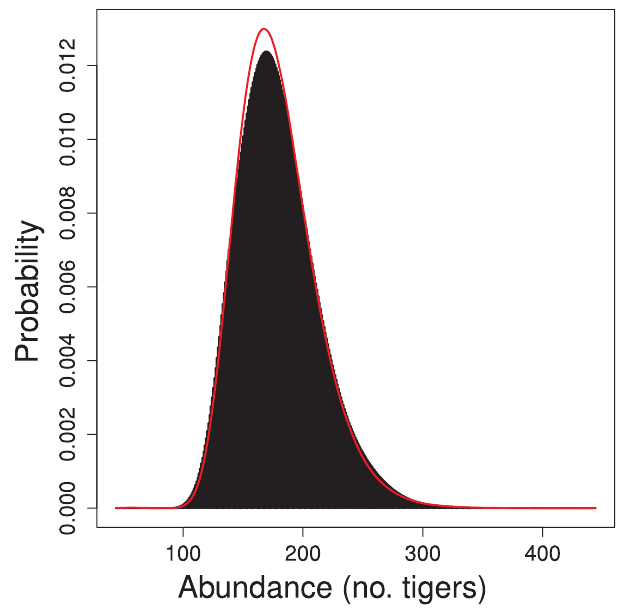
Figure 5. Posterior distribution of abundance of tigers in a rectangular region of area 1452 km 2 . Region is defined as trapping rectangle buffered by 5 km. Red line indicates the estimated sampling distribution of empirical Bayes estimates of abundance.